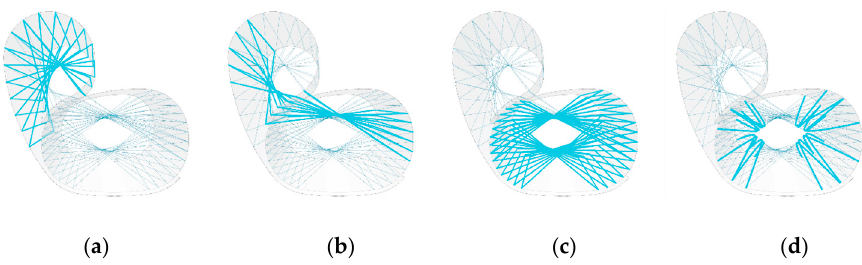
Figure 22. Syntax layers: ( a ) back surface layer; ( b ) bracing layer between seat and back; ( c ) seat surface layer; ( d ) seat bracing layer.